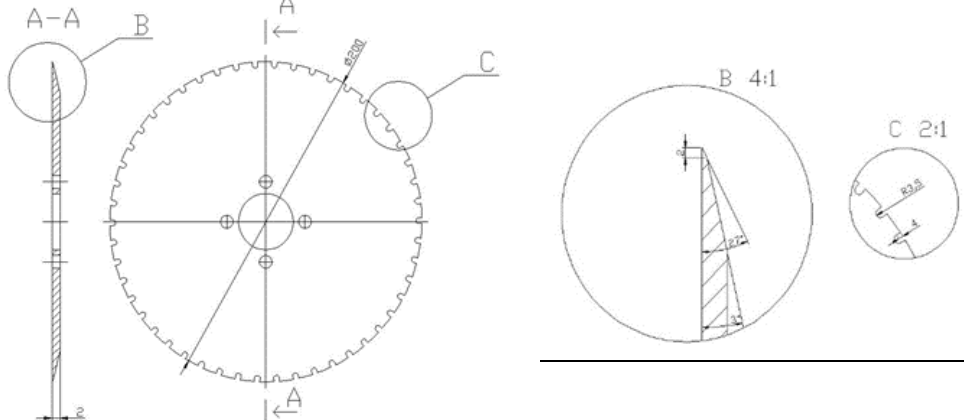
Figure 6. Main geometric dimensions of disc knives for cutting onion ends. For cutting the outer layer of the material (onion scales), a pair of knives operating in the horizontal plane and a pair of knives operating in the vertical plane were used. The geometrical form of the knives for cutting the scale in the horizontal and vertical planes together with the cutting system are presented in Figure